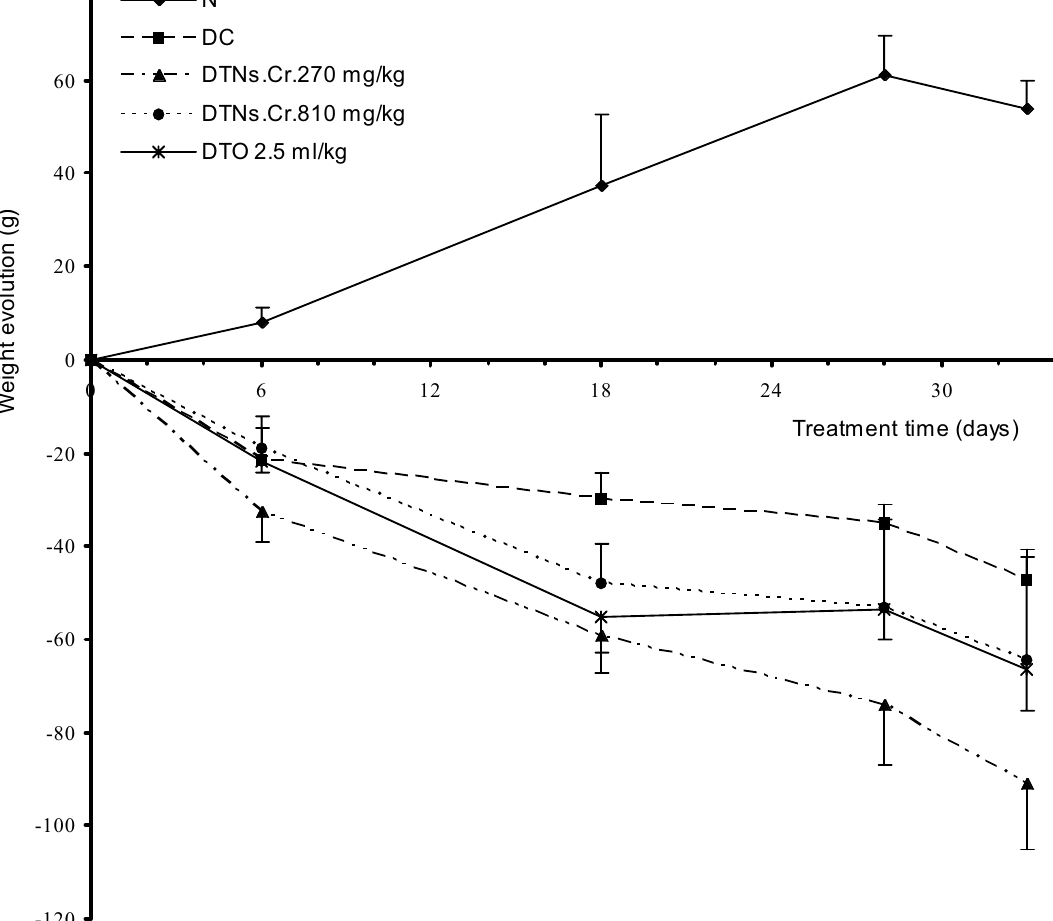
Figure 1. Effects of N. sativa extracted and oil on body weight evolution. N, normal rats group (n=5); DC, dia- betic control rats group (n=5); DTNs.Cr, N. sativa crude extract treated diabetic rats group (n=5); DTO, oil treat- ed diabetic group (n=5). Values are expressed as mean ± SEM. *Significantly different from N-rats group by ANOVA test, § Significantly different from N-rats group by ANOVA test p <